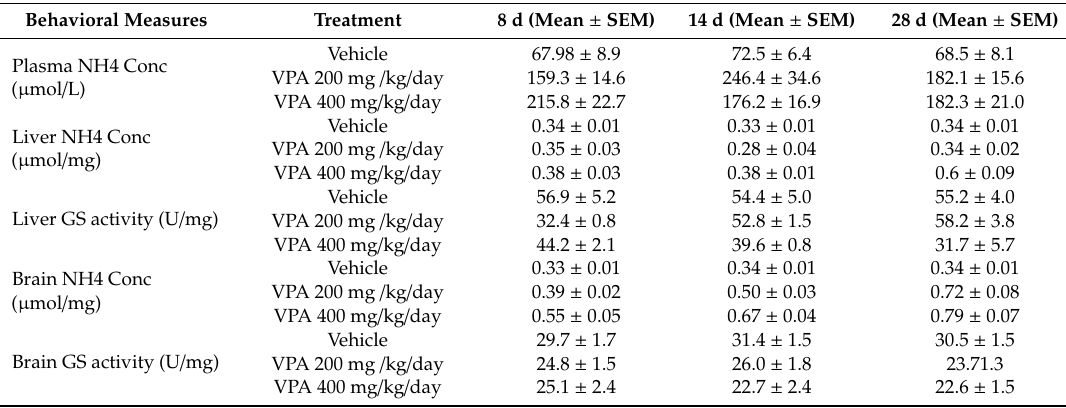
Figure 1. The e ff ect of VPA on behavioral manifestations and plasma ammonia (NH 4 ) concentration. ( A ) VPA treatment shows significant e ff ect on Irwin’s total score: F 2,50 = 15.97, p < 0.0001 by two-way ANOVA ( n = 6 / group). Significant di ff erences were observed at 8 d of treatment between vehicle and VPA 400 mg / kg / d (mean di ff erence, 95% CI, p value: 7.00, 0.4291 to 13.57, p = 0.037) and at 14 days of treatment between vehicle and VPA 200 mg / kg / d (mean di ff erence, 95% CI, p value: 5.50, 1.250 to 9.750, p = 0.012) and at 28 d of treatment between vehicle and VPA 400 mg / kg / d (mean di ff erence, 95% CI, p value: 5.417, 0.6275 to 10.21, p = 0.029) by Tukey’s multiple comparisons test. ( B ) VPA treatment has significant e ff ect on plasma NH 4 concentration: F 2,15 = 50.42, p < 0.0001 by two-way ANOVA ( n = 6 / group). Significant di ff erences were observed at 8 d of treatment between vehicle and VPA 200 mg / kg / d (mean di ff erence, 95% CI, p value: − 91.34, − 140.2 to − 42.50, p = 0.001) and between vehicle and VPA 400 mg / kg / d (mean di ff erence, 95% CI, p value: − 147.9, − 221.1 to − 74.66, p = 0.001), and at 14 d of treatment between vehicle and VPA 200 mg / kg / d (mean di ff erence, 95% CI, p value: − 173.9, − 286.1 to − 61.71, p = 0.008) and between vehicle and VPA 400 mg / kg / d (mean di ff erence, 95% CI, p value: − 103.6, − 158.3 to − 48.97, p = 0.002), and at 28 d of treatment between vehicle and VPA 200 mg / kg / d (mean di ff erence, 95% CI, p value: − 113.6, − 164.4 to − 62.77, p = 0.0006) and between vehicle and VPA 400 mg / kg / d (mean di ff erence, 95% CI, p value: − 113.8, − 181.6 to − 46.05, p = 0.004) by Tukey’s multiple comparisons test. ( C ) Significant negative correlation between total Iriwn’s scale scores and plasma ammonia (NH 4 ) concentration: r = − 0.4498, p = 0.0006. Table 2. The e ff ect of VPA on plasma, liver and brain ammonia (NH 4 ) concentration, and on liver and brain, prefrontal cortex (PFC), striatal (Str), and cerebellar (Cere) NH 4 concentration and glutamine synthetase (GS) enzyme activity. Data presented as mean ± SEM ( n = 6 /